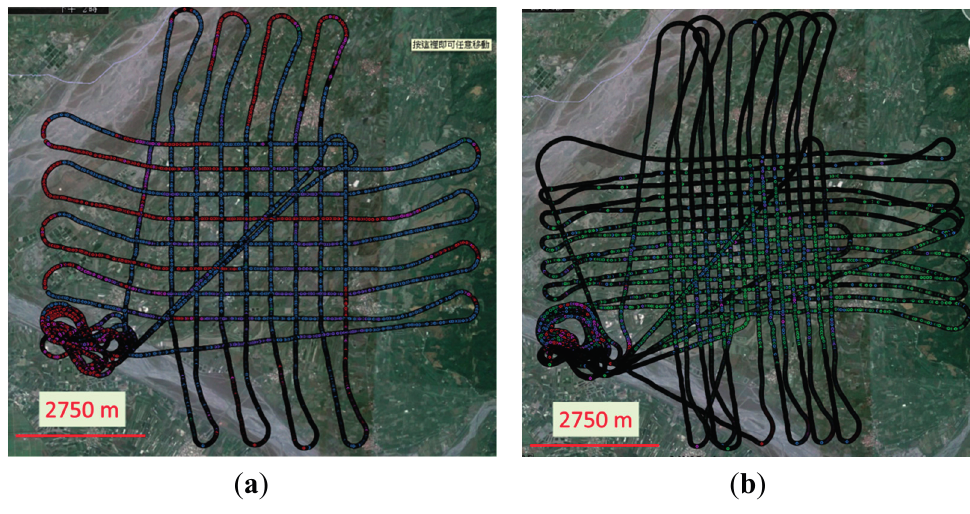
Figure 20. The trajectories of the second test flight. ( a ) UAV-ADIS-600; ( b )